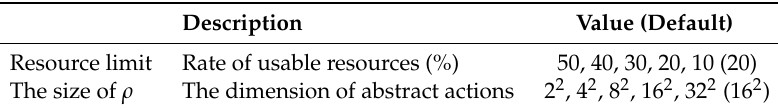
Table 4. VOL parameter setting in the case study